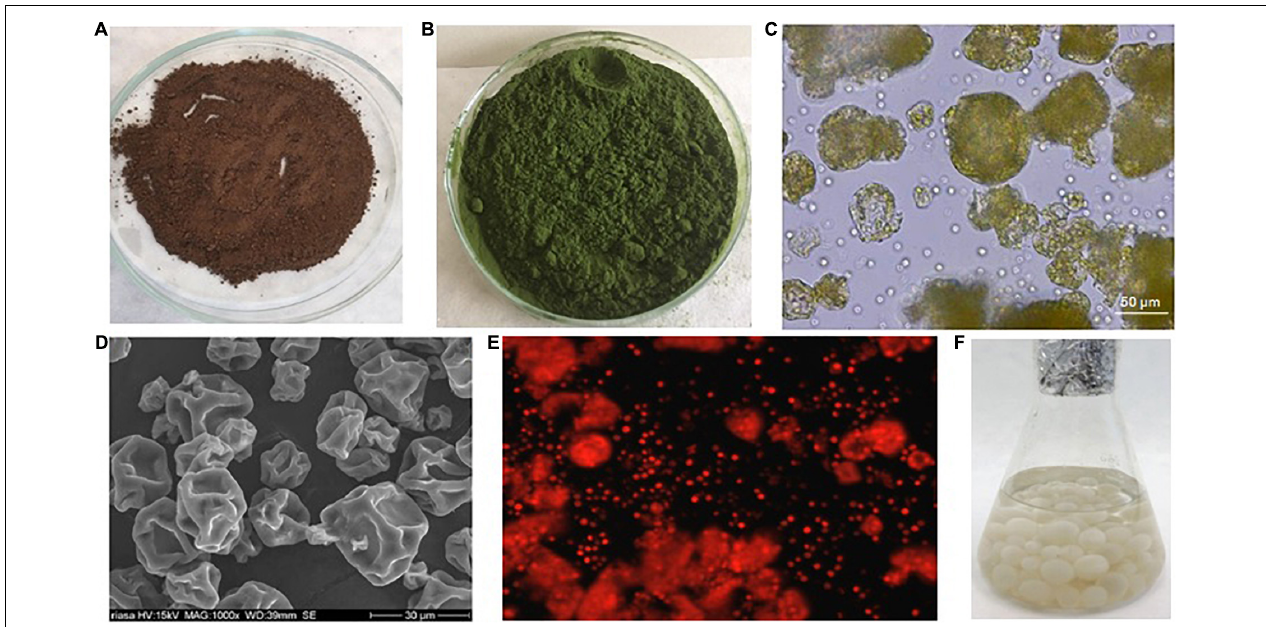
FIGURE 1 | (A) Treated ash substrate from the sludge incinerator. (B) Dry biomass of the green alga Chlorella sp. after pre-treatment. (C) Dry biomass of the green alga Chlorella sp. in a light microscope. (D) Dry biomass of the green alga Chlorella sp. in SEM. (E) Dry biomass of the green alga Chlorella sp. in a fluorescence microscope. (F) Pellets of Aspergillus niger after washing in distilled water.